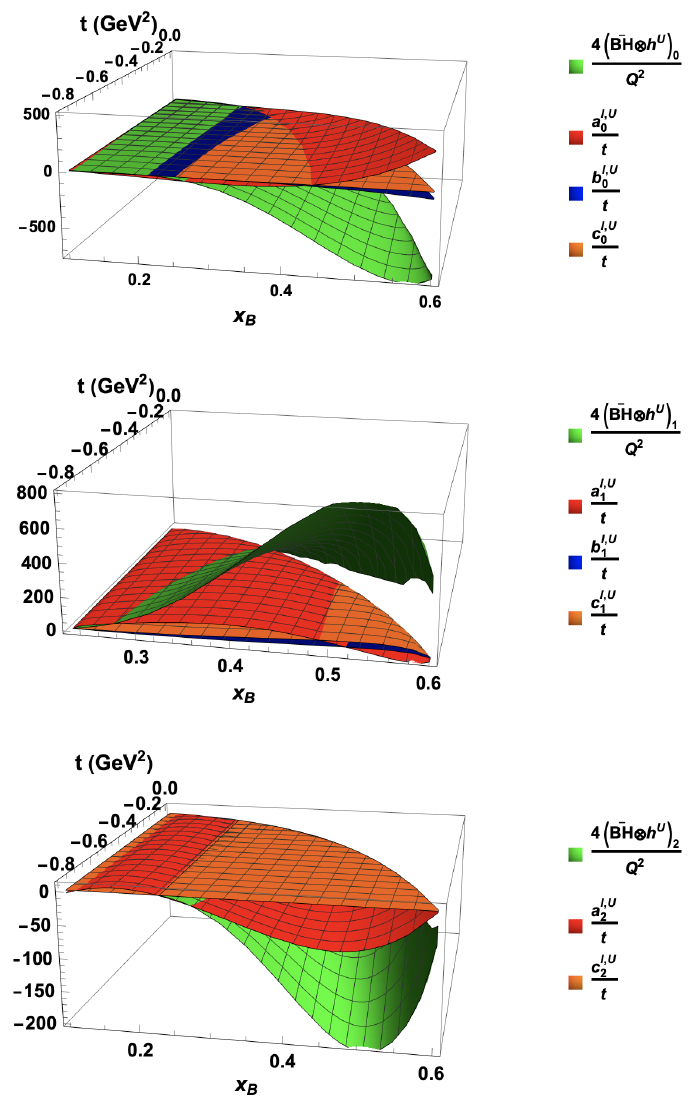
Figure 1. The unitless kinematical coefficients present in the reduced UU cross section for harmonics cos(0 φ ) (top), cos(1 φ ) (middle) and cos(2 φ ) (bottom). They are plotted at the kinematics given in eq.